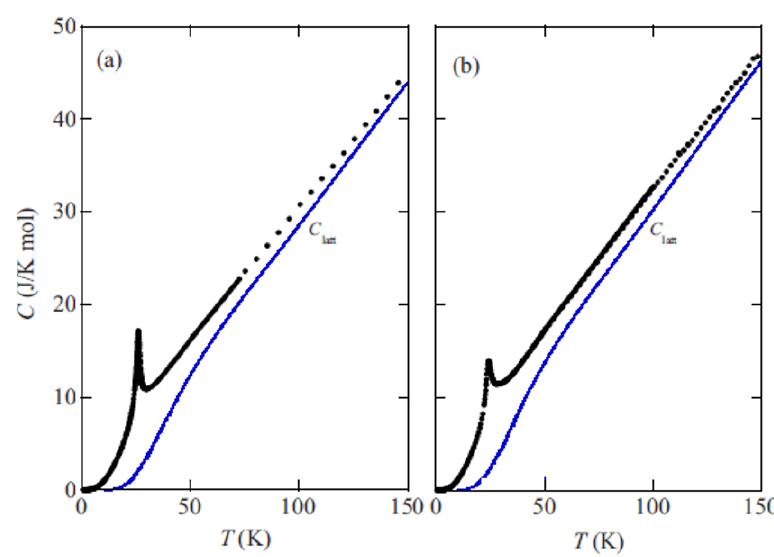
Figure 7. Temperature dependence of specific heat (C) of CuCr